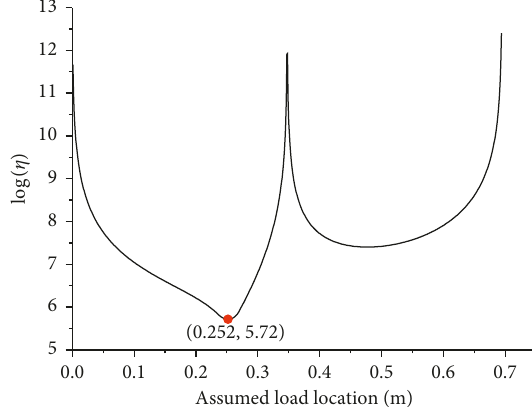
Figure 17: The optimization function value of impact B.